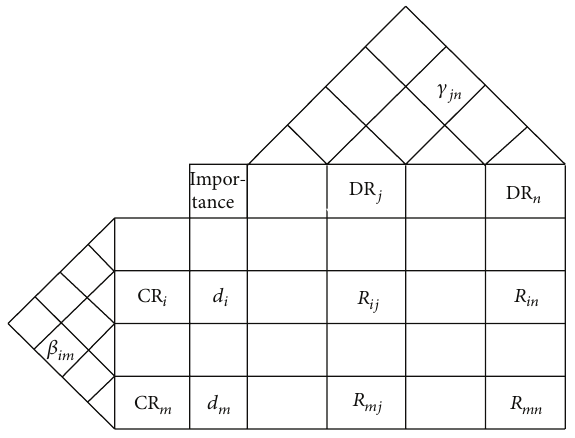
Figure 2: General HOQ structure.